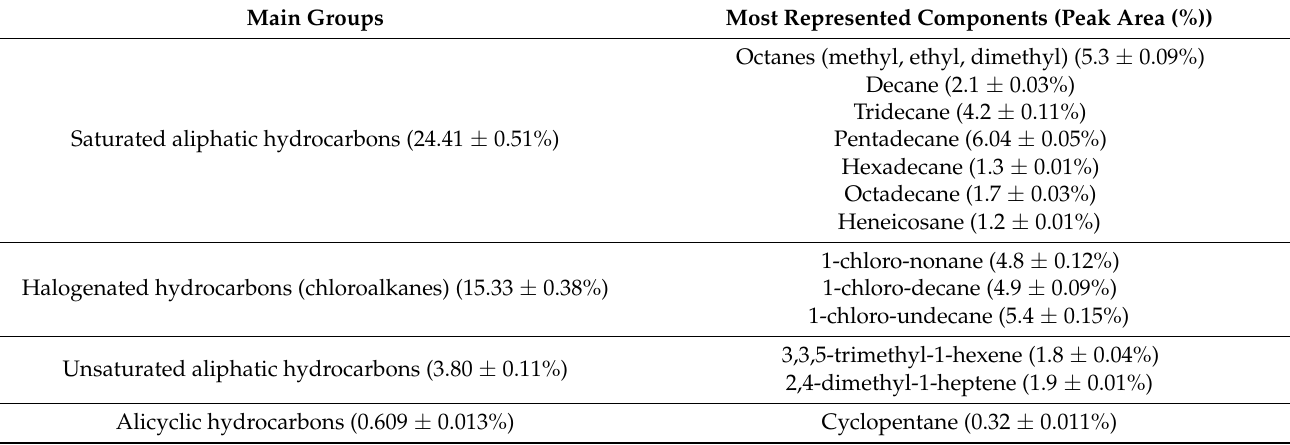
Table 2. Composition of the oil phase (peak area (%)) at 425 ◦ C and 60 min. Main